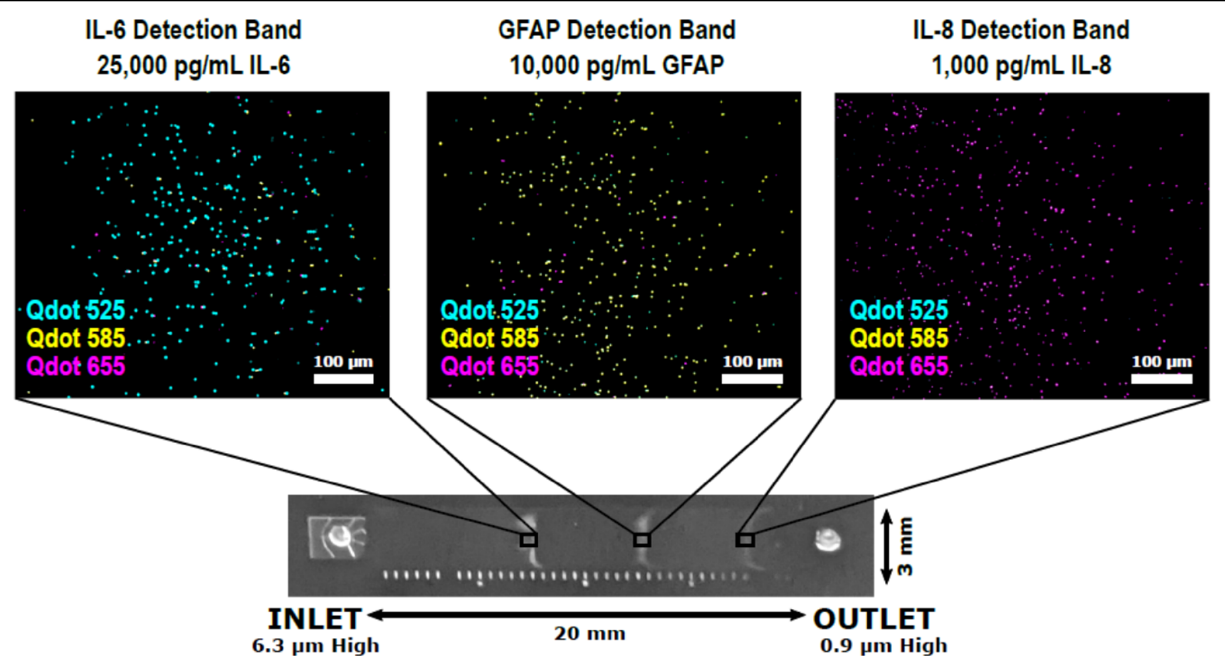
Figure 3. The variable height device from Krausz et al. designed to passively multiplex bead-based QLISAs (quantum dot-linked immunosorbent assays) for GFAP, IL-6, and IL-8 [46].